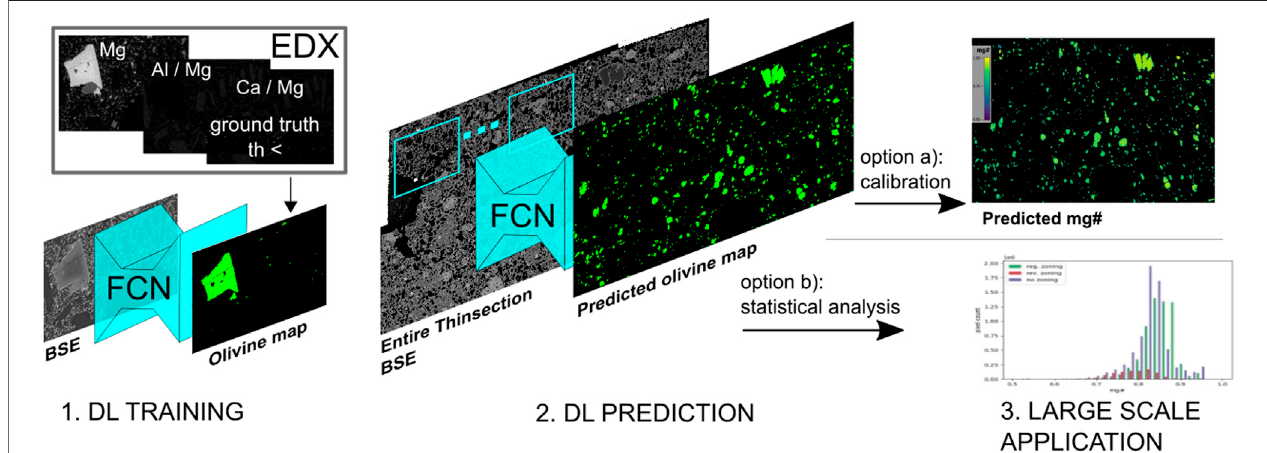
FIGURE 2 | Working protocol of the presented method. 1. DL Training: BSE images are used as input and ground truth is generated from EDS data. 2) DL Prediction: Olivine segmentation from BSE image. 3. a) Calibration: Estimation of the relationship between EPMA and BSE values to determine mg# . For the pixels that are classi fi ed as Olivine, mg# values are predicted based on regression parameters. 3. b) Statistical analysis based on olivine segmentation.